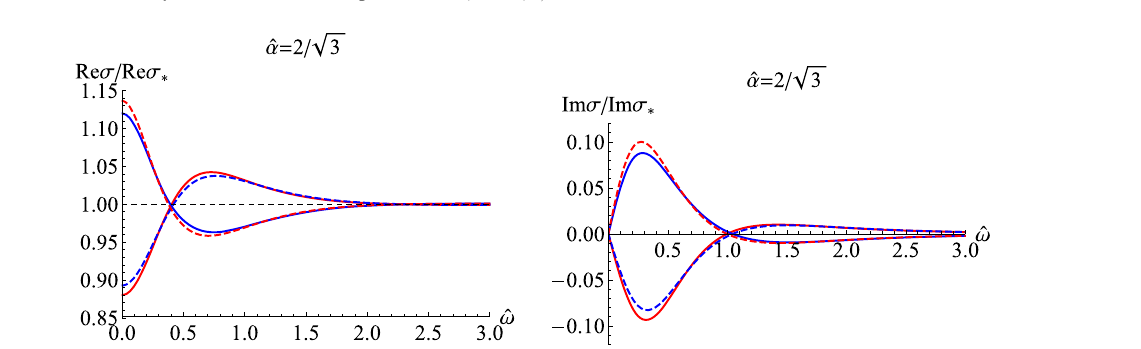
Fig. 10 The DC conductivity σ 0 versus ˆ α for the representative γ and γ 1 , 0